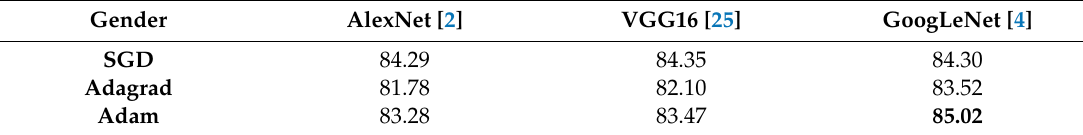
Table 4. Gender classification results of the CIA database by the three CNNs.